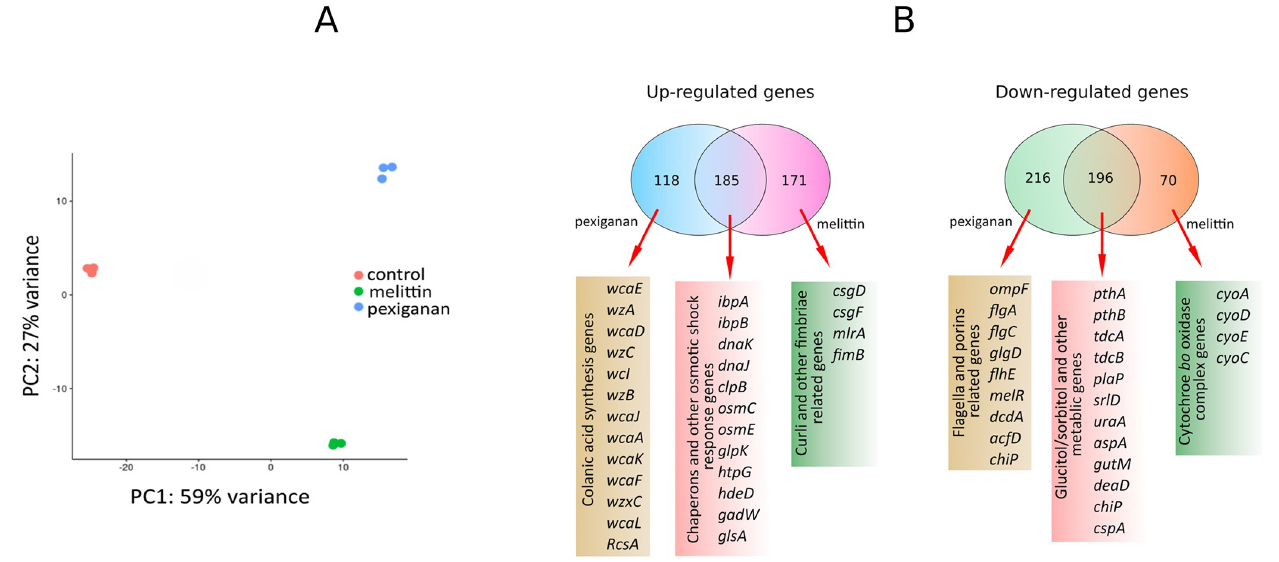
Fig 4. Gene expression in primed E . coli . (A) Principal component 1 separates the control from the peptide priming, PC2 separates the melittin induced response from the pexiganan response. (B) Venn diagrams showing specific and overlapping responses of E . coli MG1655 to priming concentrations of melittin and